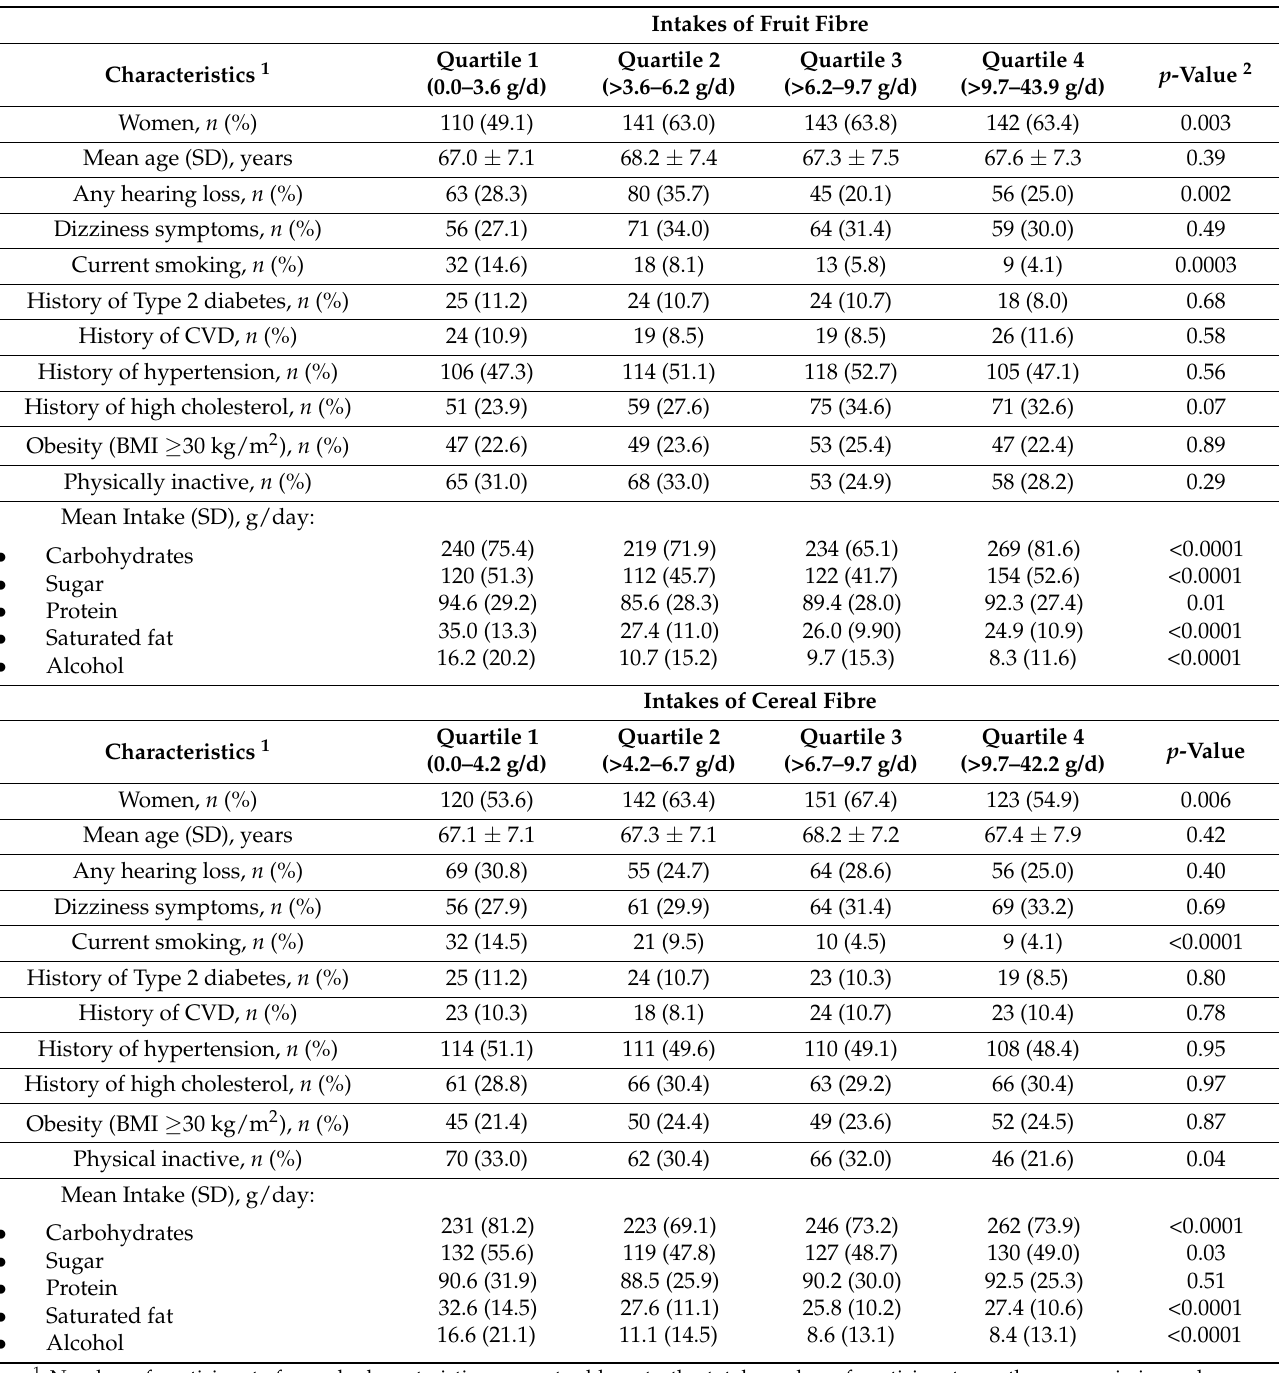
Table 1. Characteristics of participants stratified by quartiles of fruit and cereal fibre intake at baseline. Intakes of Fruit